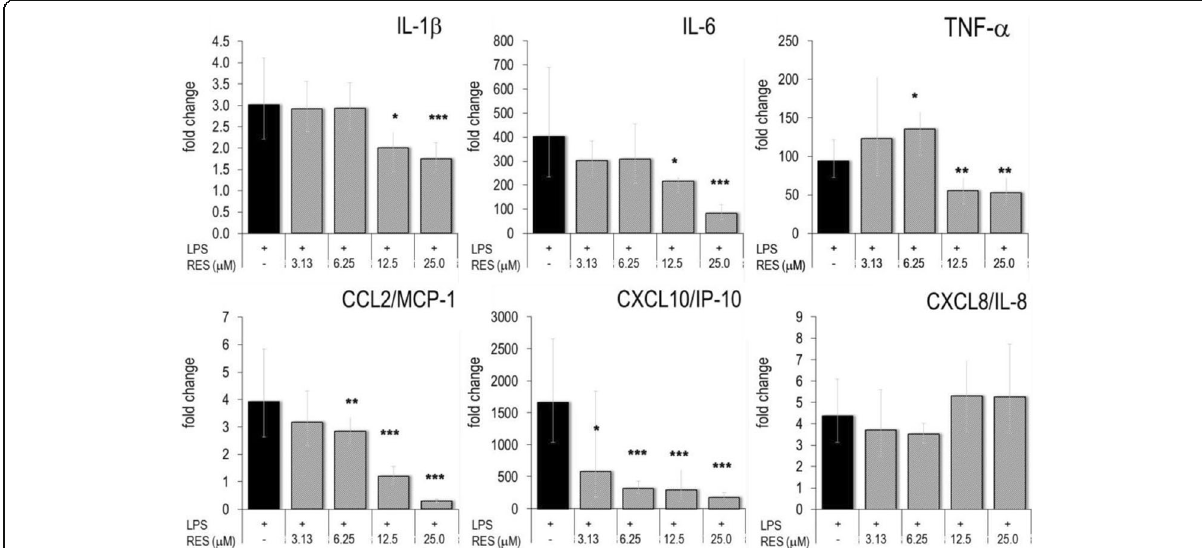
Fig. 3 Effect of RES on gene expression in activated THP-1. PMA-treated THP-1 cells were cultured in the presence of indicated concentrations of RES and activated with LPS for 4 h. RT-PCR was performed and the gene expression levels were indicated as mean fold changes (± errors) (versus unstimulated cell) (see also reference [11]). * p < 0.05, ** p < 0.01, *** p < 0.001 (versus LPS-stimulated cells)